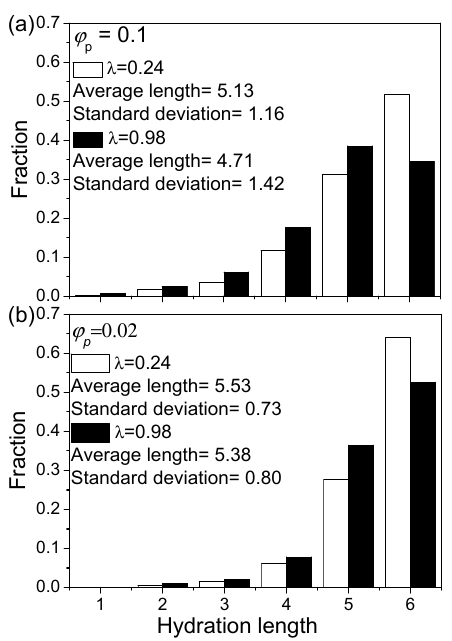
Figure 6. Histogram showing the length of solvated B-bead segments at various conditions from the outer skin only: ( a ) ϕ p = 0.1 and ( b ) ϕ p =